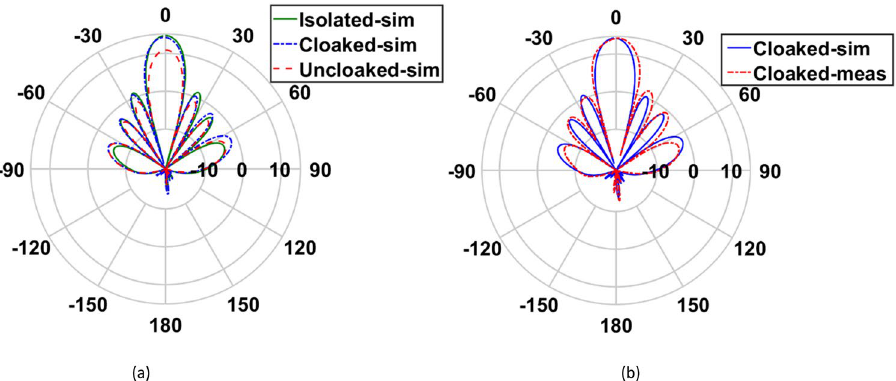
Figure 15. ( a ) Comparison between the gain pattern of array II in isolated, cloaked and uncloaked cases, ( b ) measured and simulated patterns of the cloaked case.